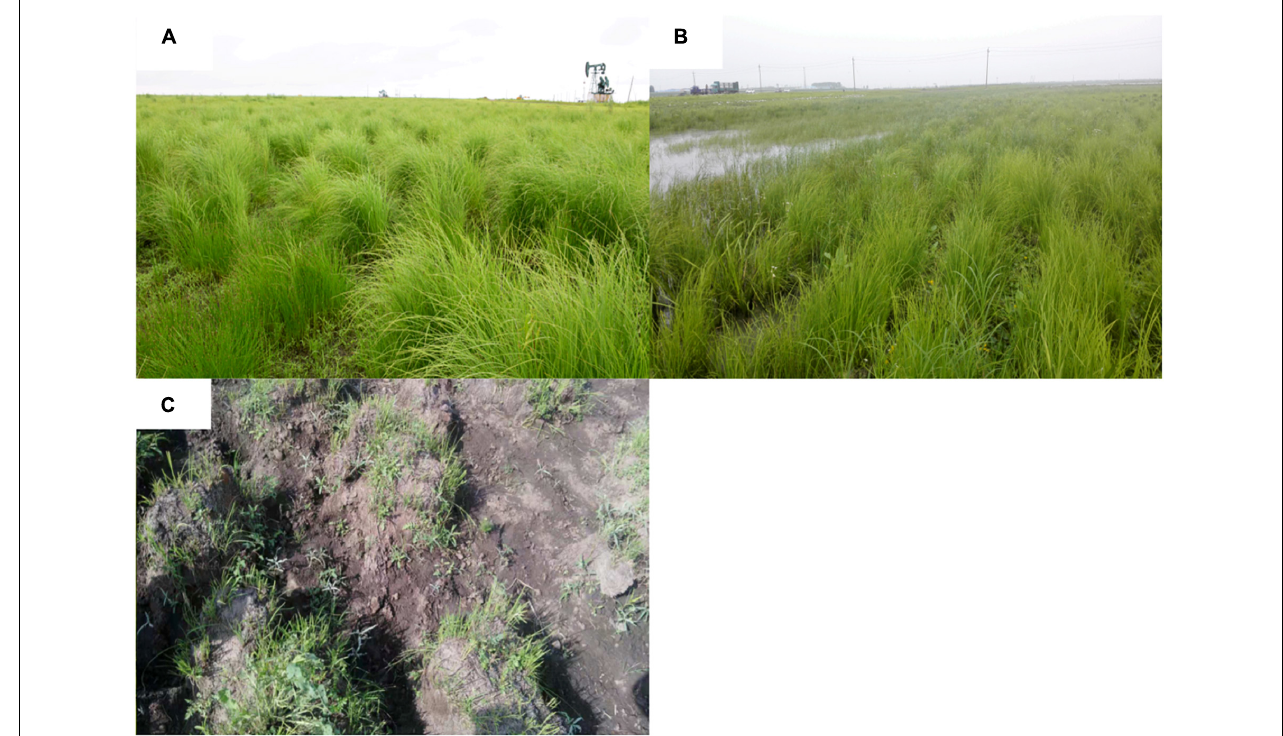
FIGURE 1 | Carex schmidtii in natural (A) , restored (B) , and degraded (C) tussock wetlands (Zhang et al., 2021b).